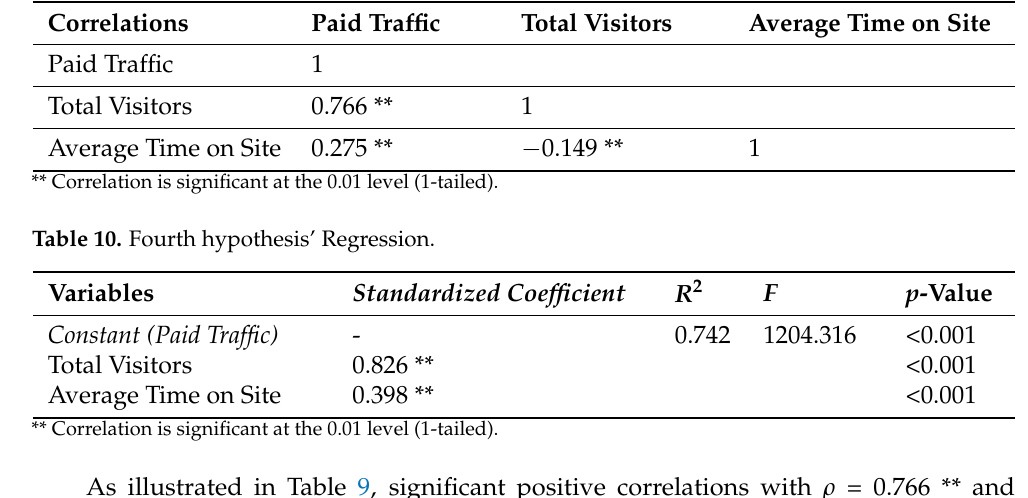
Table 9. Coefficients between the examined metrics for H4.